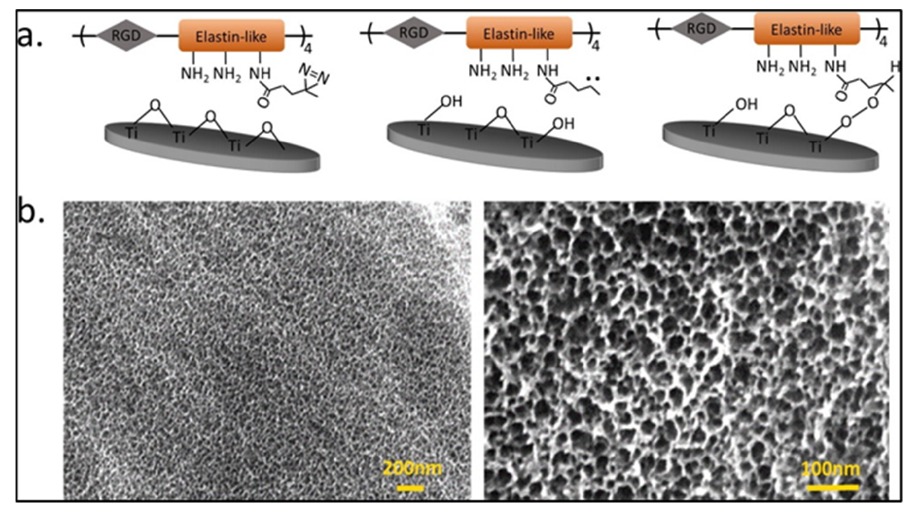
Figure 4. Surface modification of Titanium substrate using elastin ‐ like polypeptide (ELP) ( a ) Shows the schematic model for conjugation of ELP onto Titanium substrates and ( b ) the SEM images of crosslinked ELP onto a Titanium substrate [107] Copyright 2019, Elsevier).